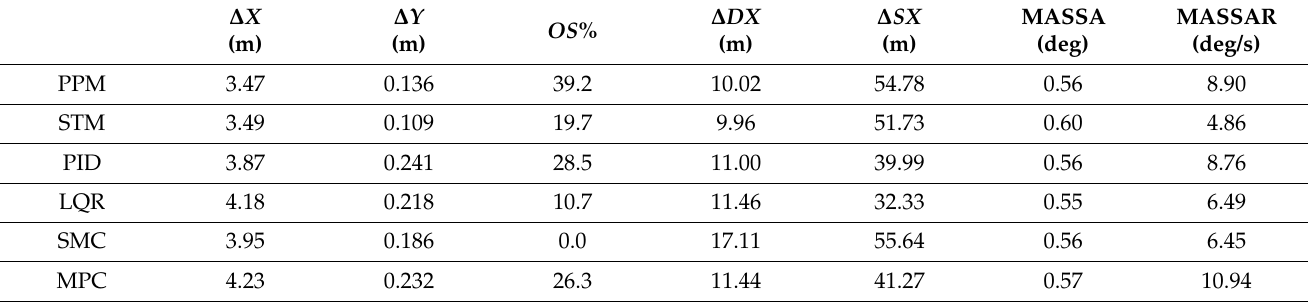
Table 4. Summary of simulation results of each controller for FWS vehicle in the second set of simulations.